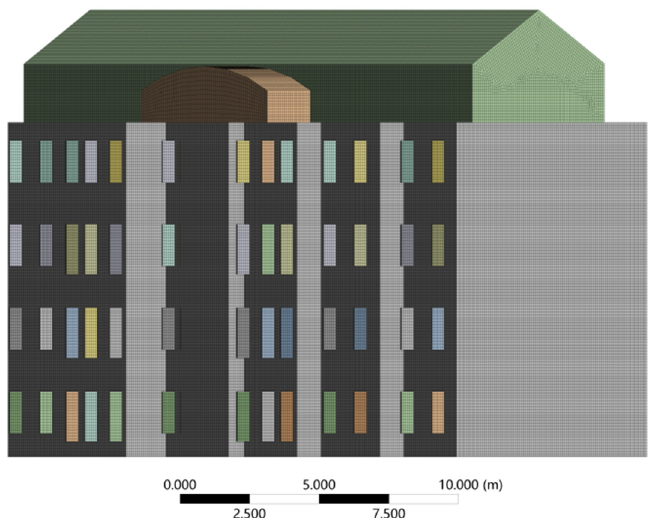
Figure 7. North-direction vertical sun visor structure grid.